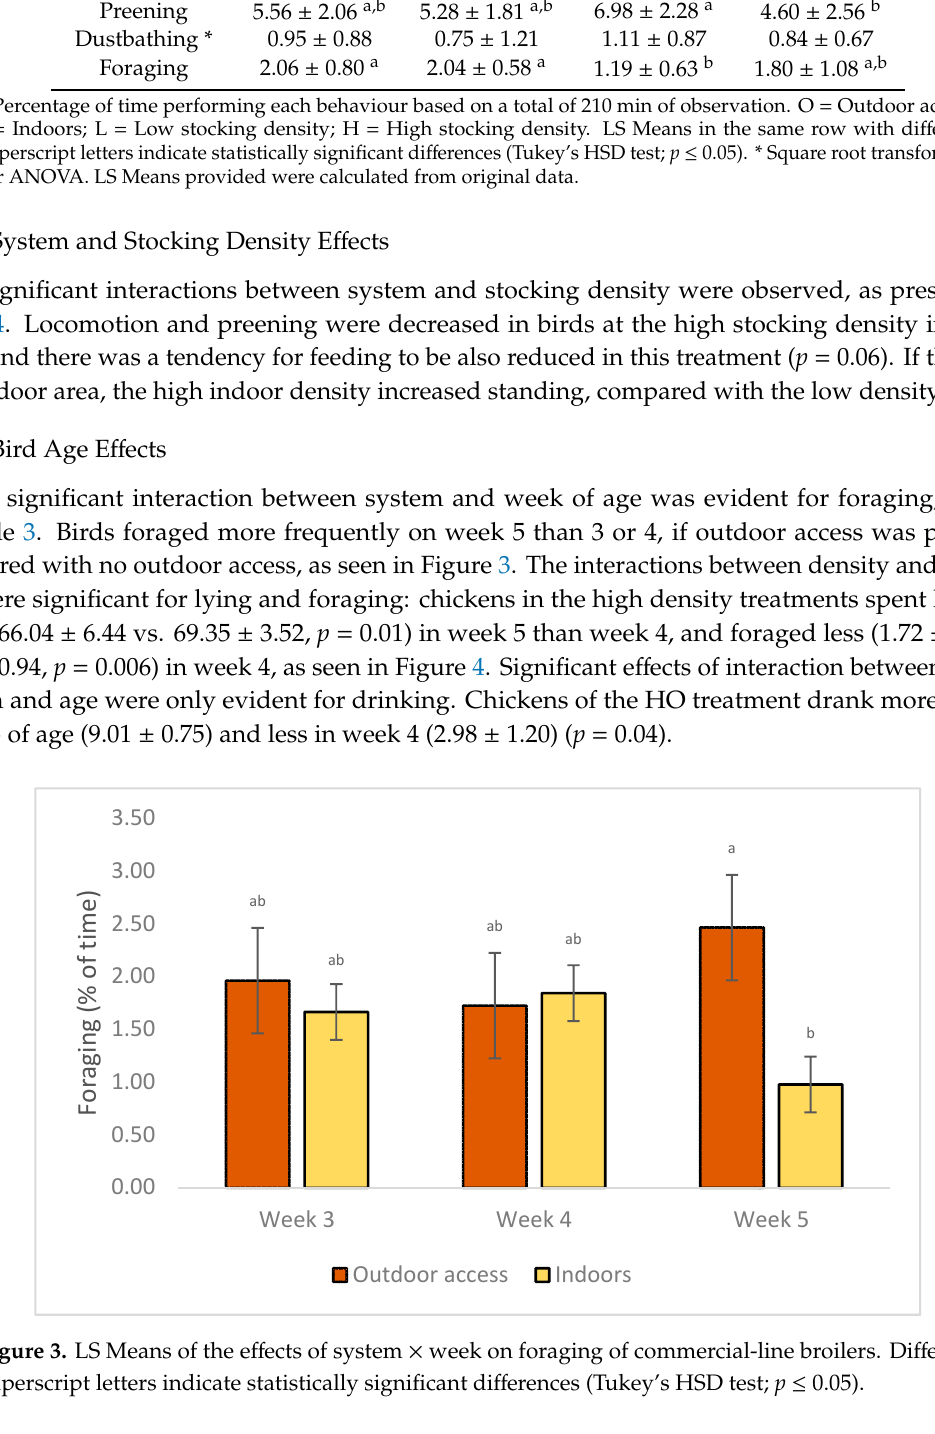
Table 4. LS Means of the effects of system × density on behaviour of commercial-line broilers 1 . Behaviour